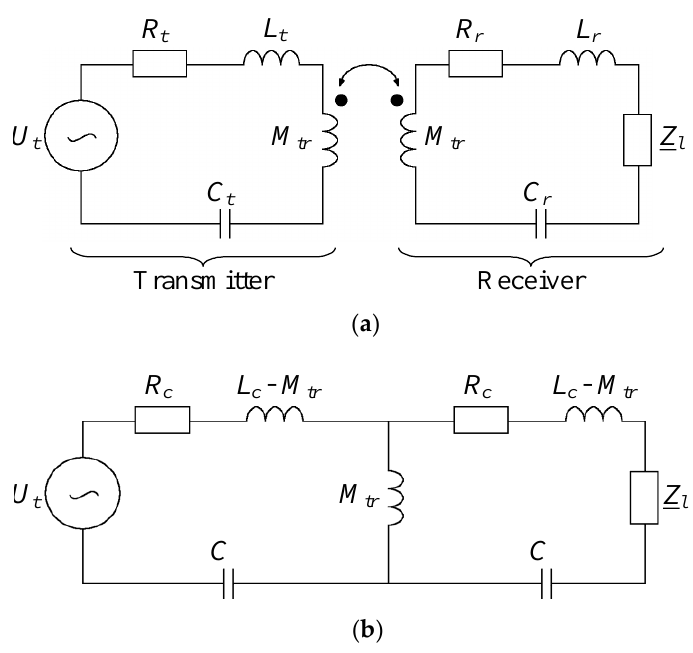
Figure 5. Circuit model of the WPT cell with identical transmitting and receiving coils: ( a ) general model of periodic cell and ( b ) simplified model of the cell for identical transmitting and receiving coil.